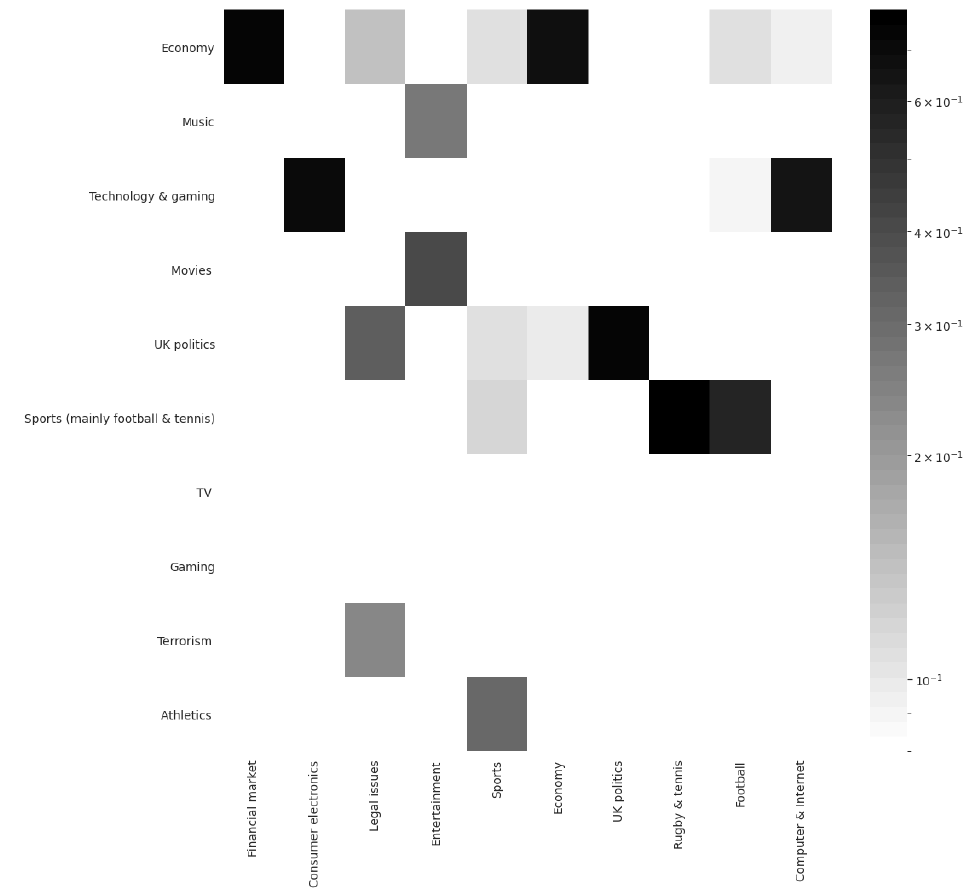
Figure 5. Heat map showing how topic terms of the k = 10 LDA topics (columns) get distributed on 10 term community topics at γ = 1.07